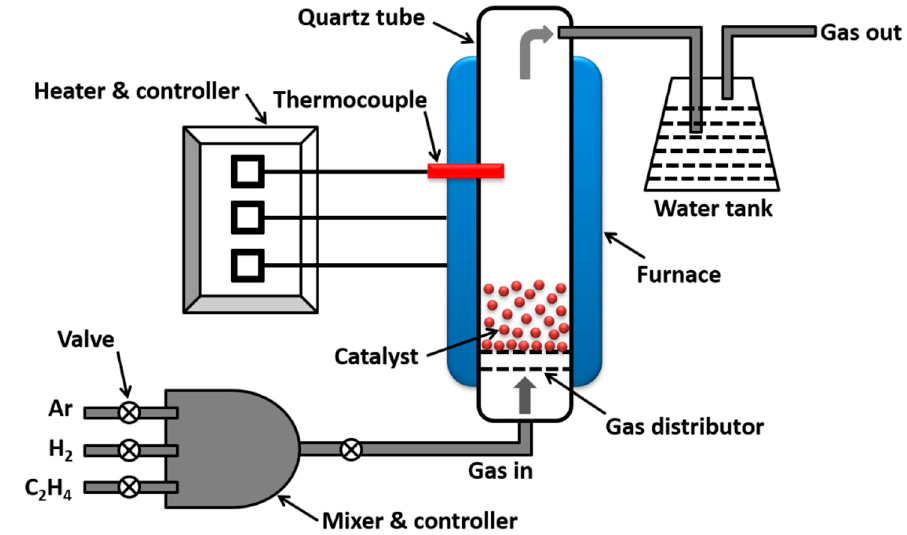
Figure 1. Schematic of fluidized bed CVD setup.